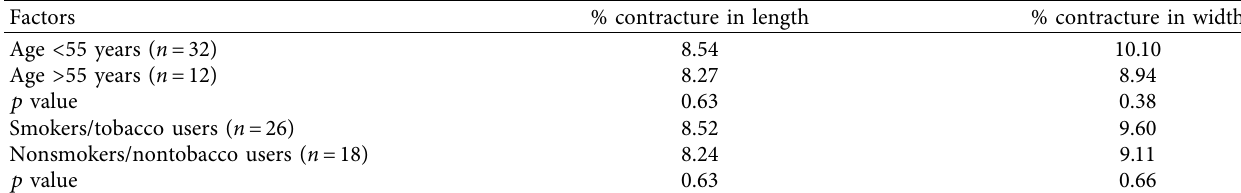
Table 3: Comparison of factors associated with the contracture of buccal mucosal graft.